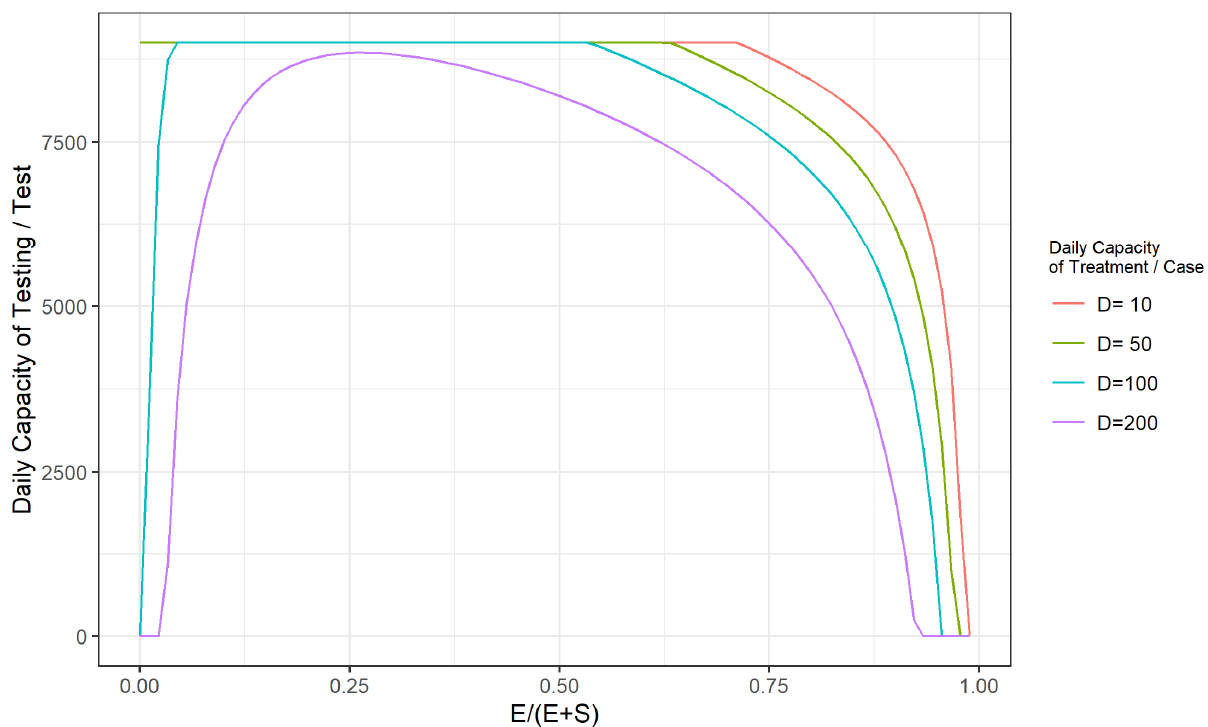
Figure A7. The effect of daily testing capacity on the ability to control the potential development level of the epidemic ( S + E = 9999, I = 0).